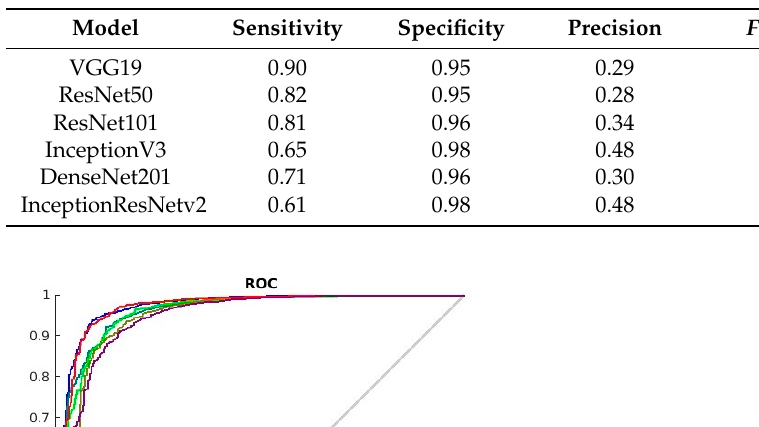
Table 5. The performance of the deep-learning models on mass classi fi cation when trained on the augmented training set .